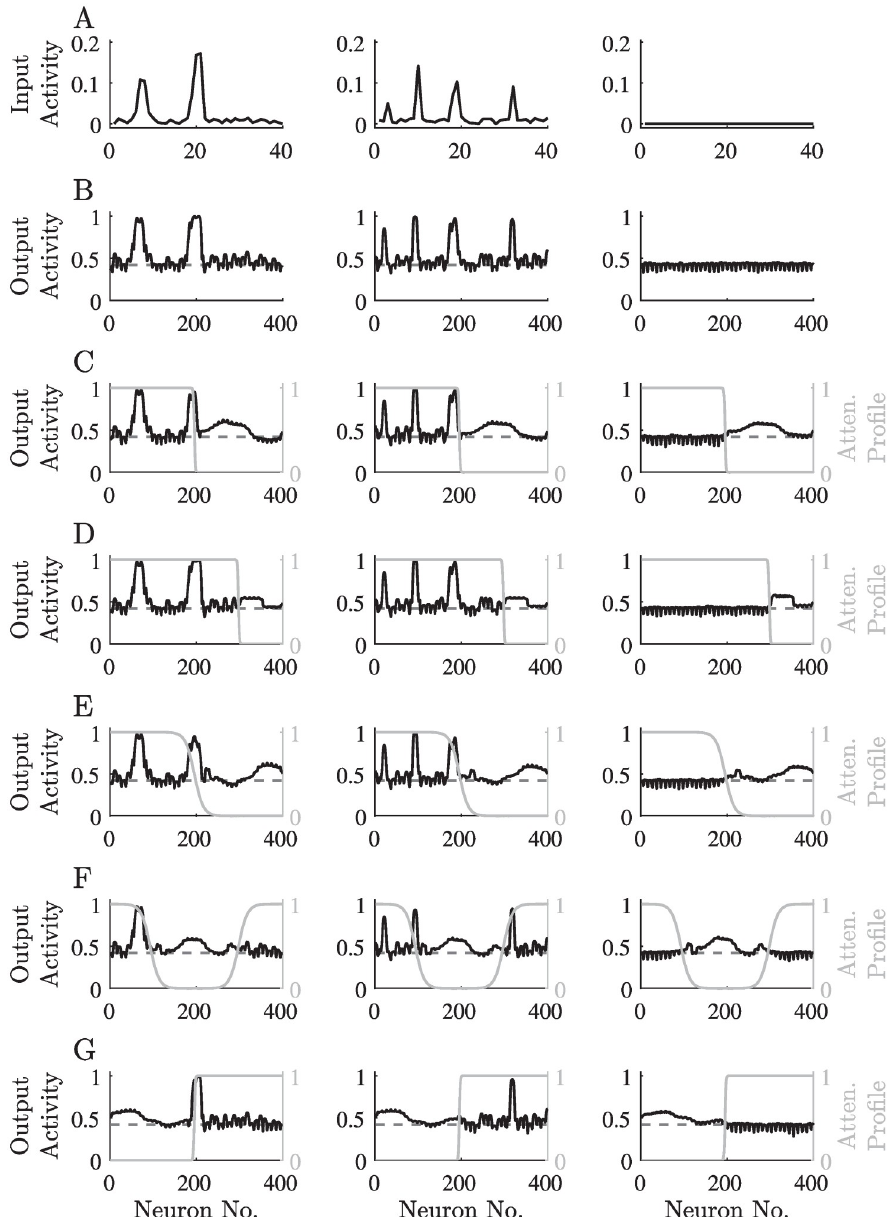
Fig 4. The network’s response to different stimuli before and after sensory deprivation. A: Typical stimuli and a silent stimulus (zero input—right panel). B: The network’s response to the stimuli presented in A. C–G: The network’s response to the stimuli presented in A after training on stimuli with an attenuated frequency range. The attenuation profiles are depicted in gray. The spontaneous activity of the output neurons, defined here as the average activity in response to a silent stimulus before attenuation (as in the right panel of B), is indicated in B–G by a dashed